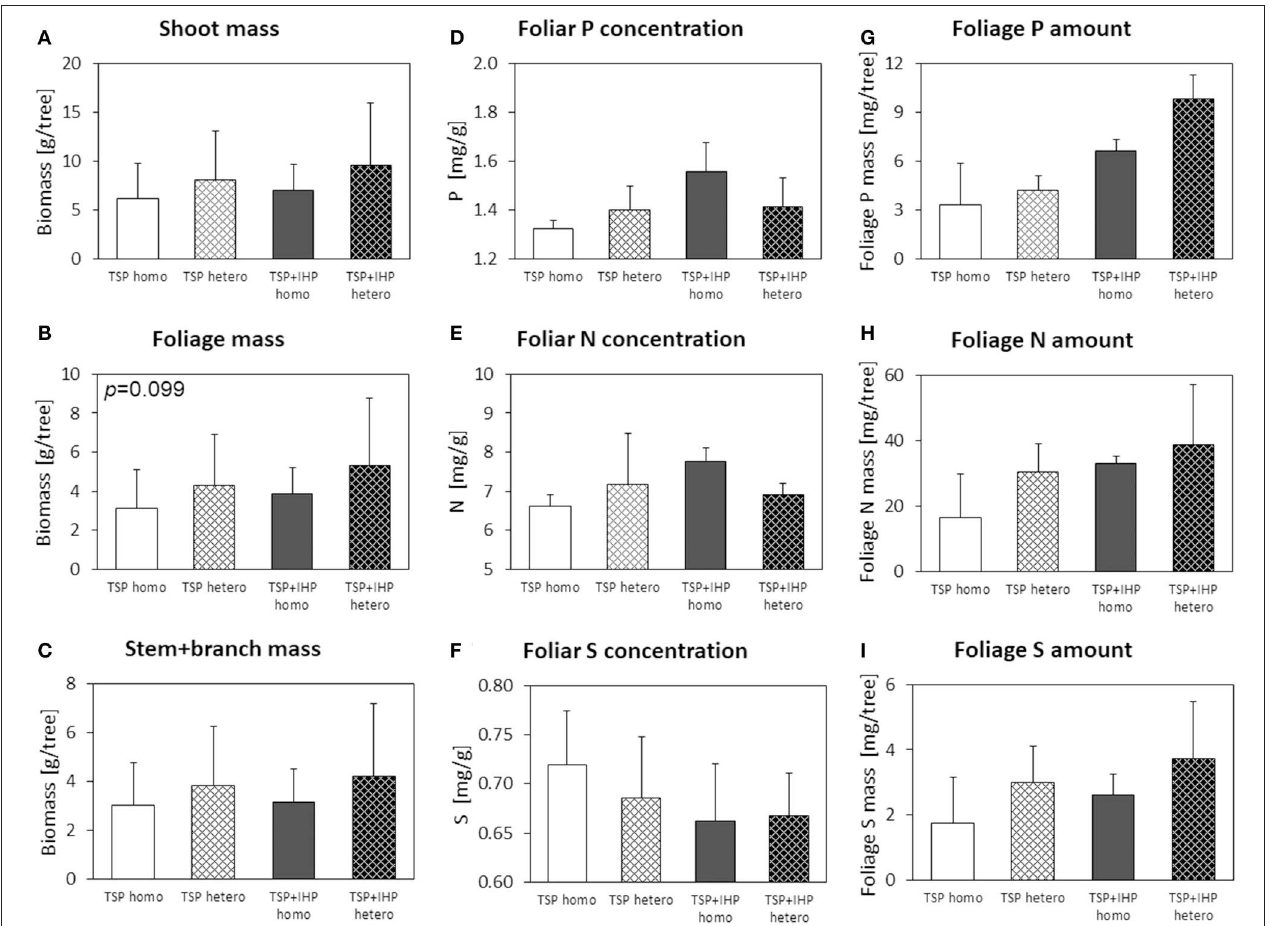
FIGURE 8 | Shoot (A) , foliage (B) , and stem + branch (C) biomass, foliar concentrations of N (D) , P (E) , and K (F) , and nutrient (P, N, K) amounts in foliage (G–I) of Picea abies with elevated N deposition at the moderate-P silicate site. Numbers in the upper left panel corner show p < 0.1 for differences between mean values of homogeneous vs. heterogeneous P application calculated by one-way